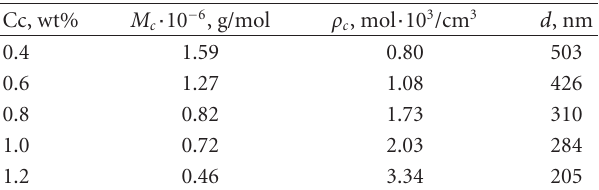
Table 5: The e ff ect of Cc on primary structural parameters of PAAG